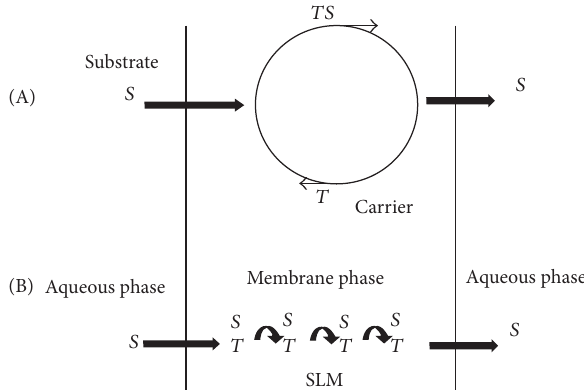
Figure 15: Possible movements of substrate across the organic phases of SLM membranes: (A) pure diffusion movement (low values of 𝐷 ∗ ), (B) movement in successive jumps (high values of 𝐷 ∗